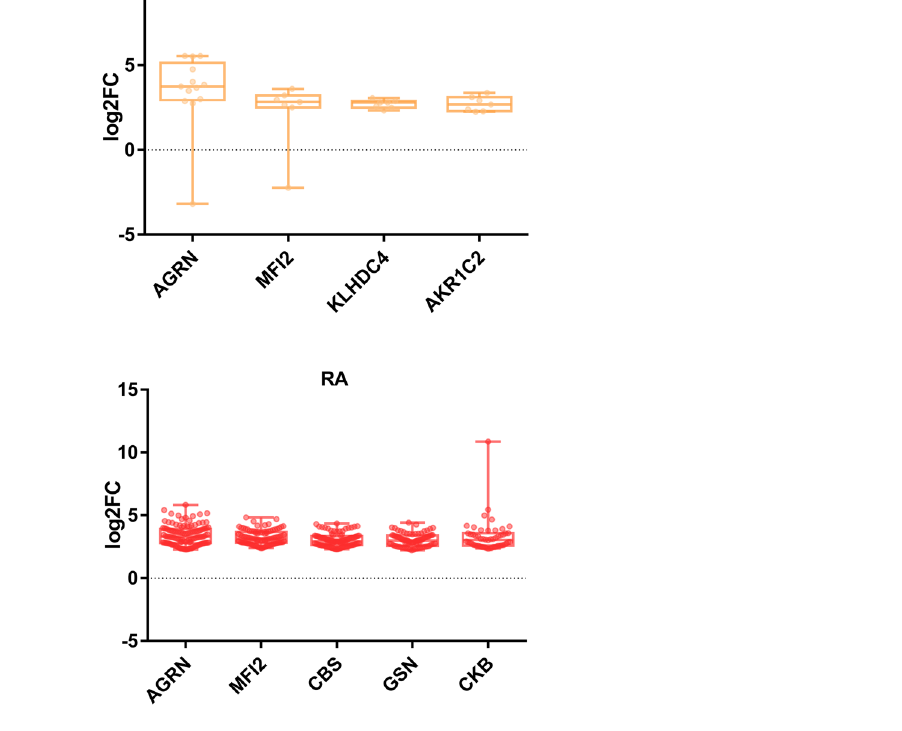
Figure 7. Proteins associated with joint diseases. Publicly available data (GSE89408) from human patients with osteoarthritis (OA) and rheumatoid arthritis (RA) indicating upregulated proteins were crossed with the data from the pararama bristles proteome. Seven proteins presented homology with upregulated proteins. The figure was drawn using GraphPad Prism version 7.0 (www.graph